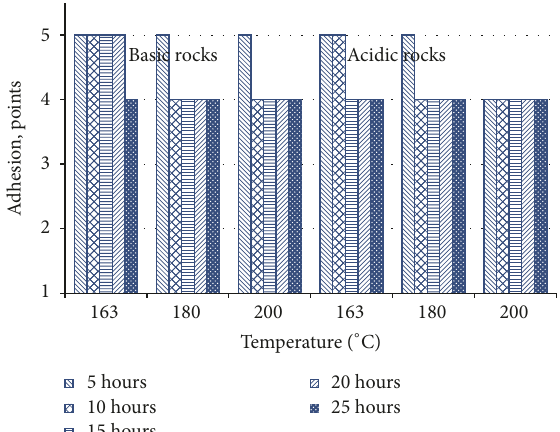
Figure 10: Thermal stability of bitumen modified with the use of